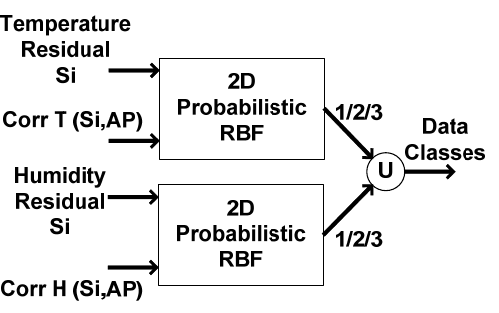
Figure 14. 2D RBF classification diagram.